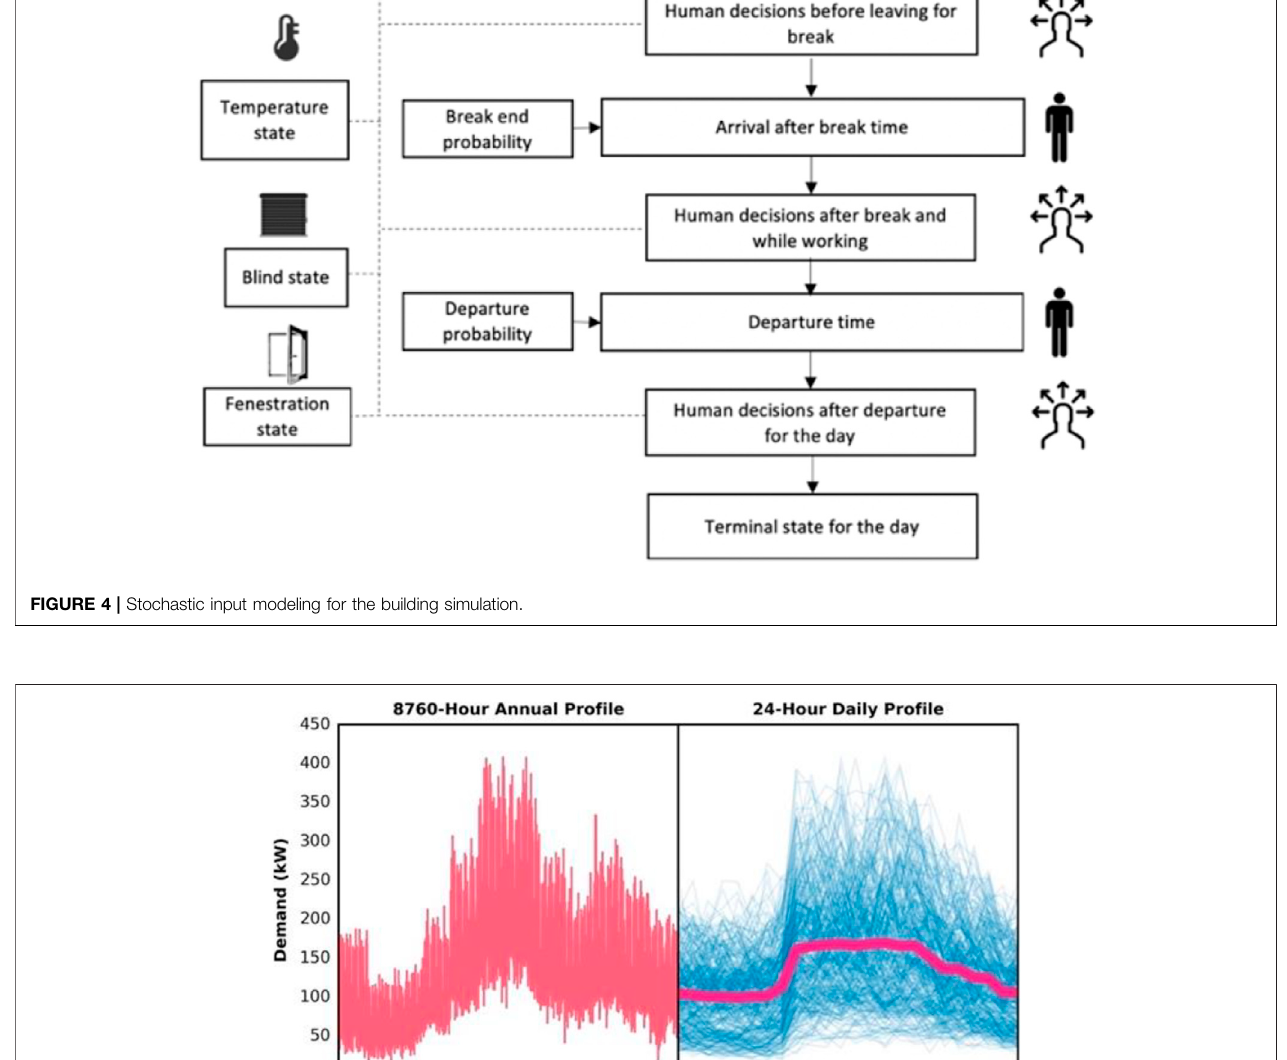
Frontiers in Energy Research |